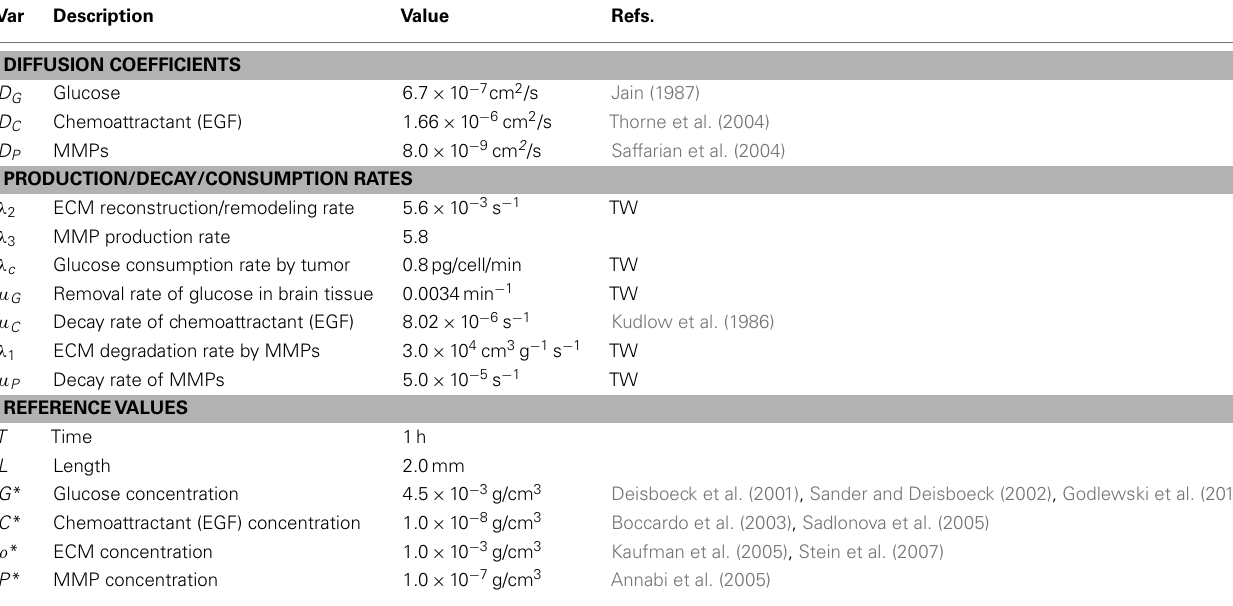
Table 1 |Values of reference variables and parameters used in the hybrid